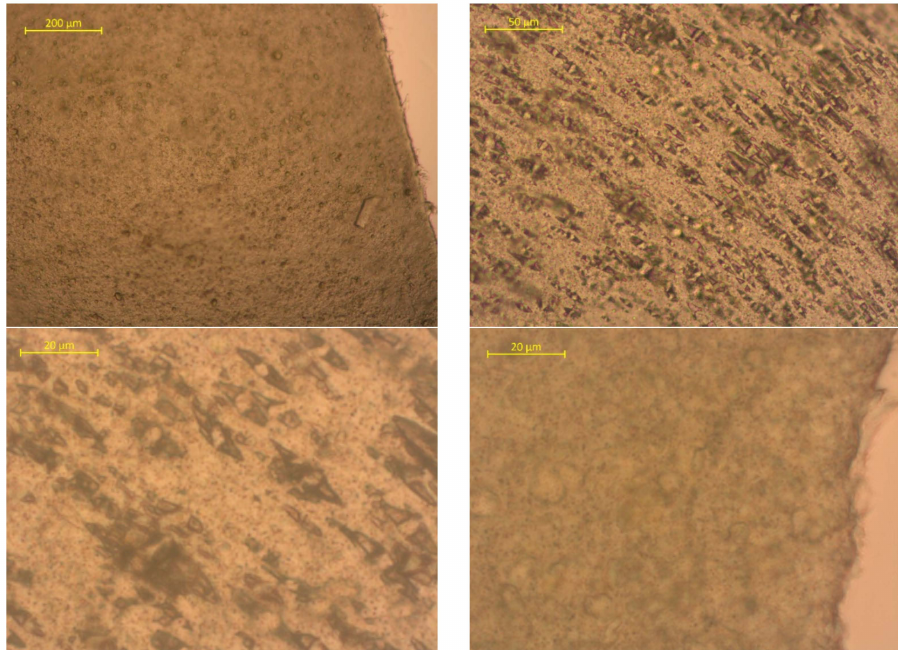
Figure 6. Surface photos of the PLA/PBAT material before composting (various magnifications).